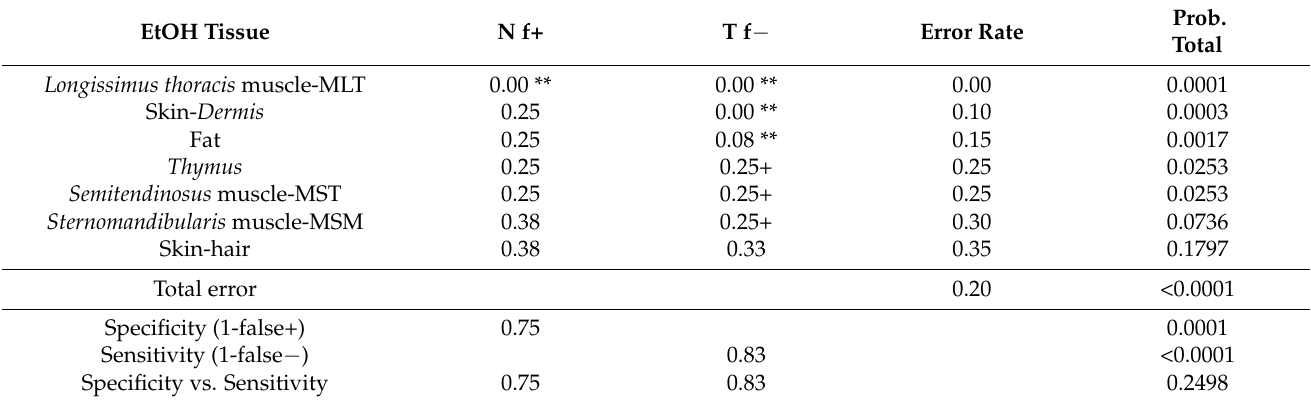
Table 1. Validated misclassification (as rate) in the control (N, false+, f+) and treated (T, false − , f − ) animals for the seven tissues over the full spectral range (350 ÷ 2500